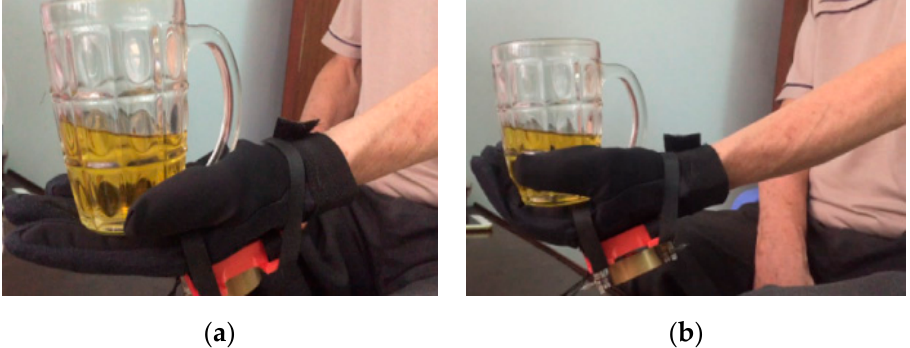
Figure 12. Experimental verification of the proposed wearable device ( a ) 1st test and ( b ) 2nd test (see here the shortcut at/sIKN8). Table 3. List of technical specifications for comparative